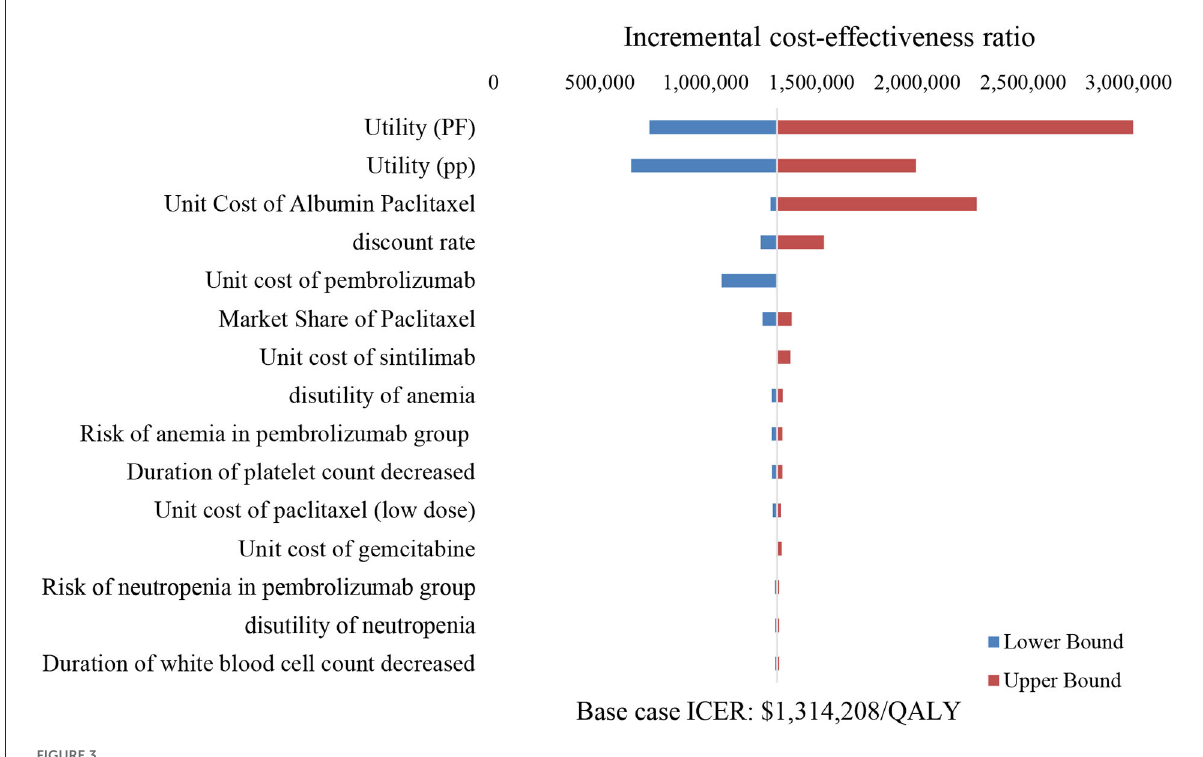
FIGURE3 Tornado diagram. PF, progression-free; PP, post-progression.